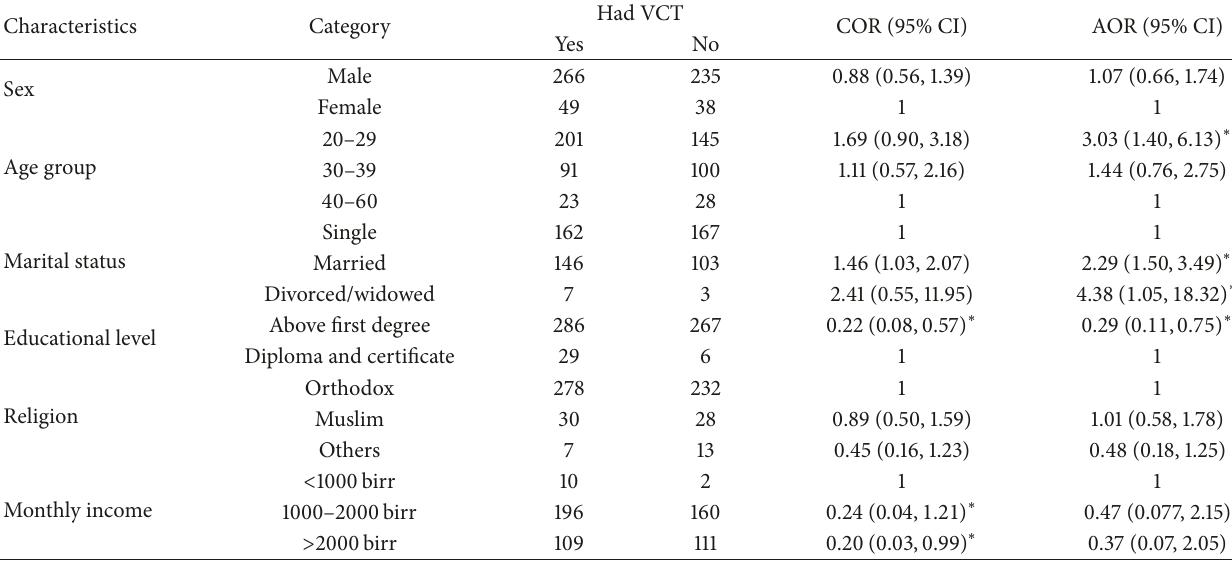
Table 4: Associations of selected sociodemographic variables with VCT service utilization among secondary school teachers in Awi Zone, Amhara Region, Ethiopia,